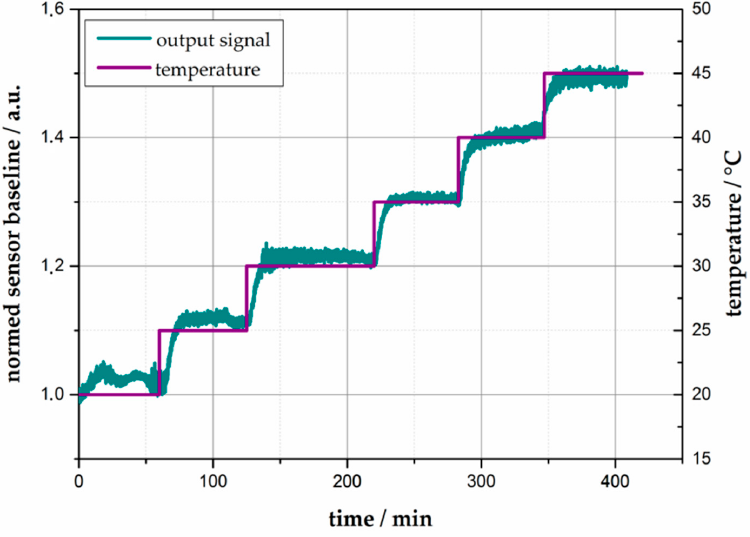
Figure 12. Temperature dependence of the maximum signal shift of 2 ∙ (A) 2 at different reaction temperatures between 10 °C and 50 °C. The colored silica was exposed to 300 ppm CO.